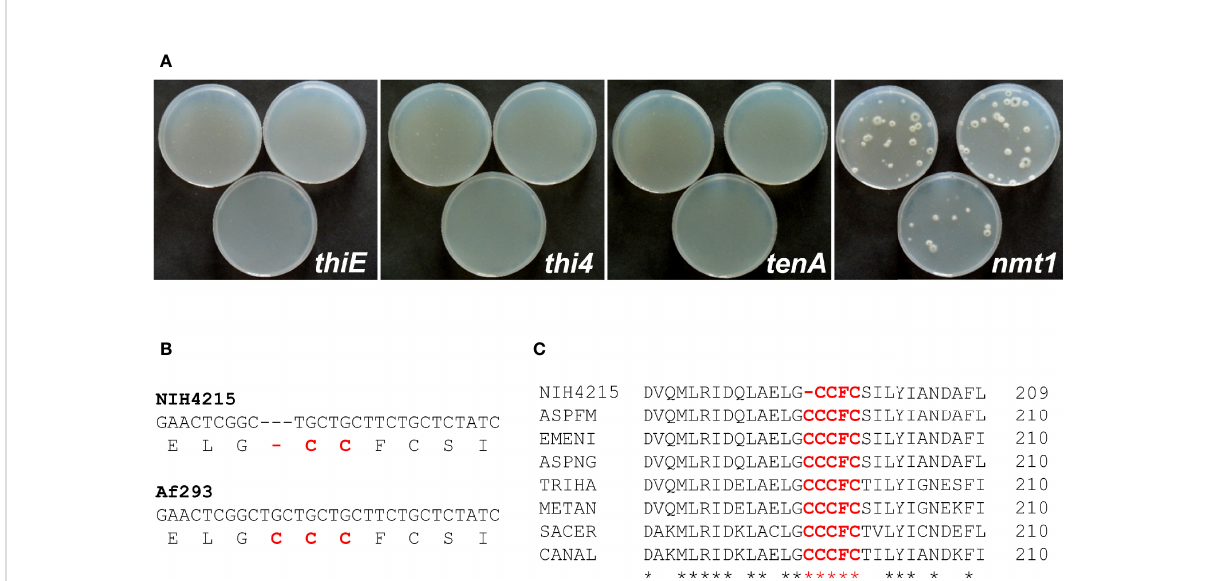
FIGURE 3 Identi fi cation of the molecular basis of thiamine auxotrophy of strain NIH4215. (A) Transformation of NIH4215 with thiamine biosynthesis genes from wild-type strain Af293. Pictures were taken at 72 h after transformation. Only the transformation with the nmt1 gene restores thiamine prototrophy. (B) Partial DNA sequence alignment of nmt1 genes from strains NIH4215 and Af293. The corresponding amino acid sequence is shown in 1-letter code. A cysteine codon present in the Af293 sequence is missing from the nmt1 gene from strain NIH4215. (C) Partial protein sequence alignment of Nmt1 homologous from various fungal species. The iron-binding motif CCCFC (highlighted) is highly conserved with one cysteine residue lacking in the sequence of NIH4215. NIH4215, A. fumigatus NIH4215 Nmt1; ASPFM, A. fumigatus Af293 Nmt1 (accession: XP_748095); EMENI, Aspergillus nidulans Nmt1 (accession: XP_681278); ASPNG, Aspergillus niger Nmt1 (accession: XP_001400160); TRIHA, Trichoderma harzianum Thi11 (accession: KKP02383); METAN, Metarhizium anisopliae Nmt1 (accession: KFG80226); SACER, S. cerevisiae